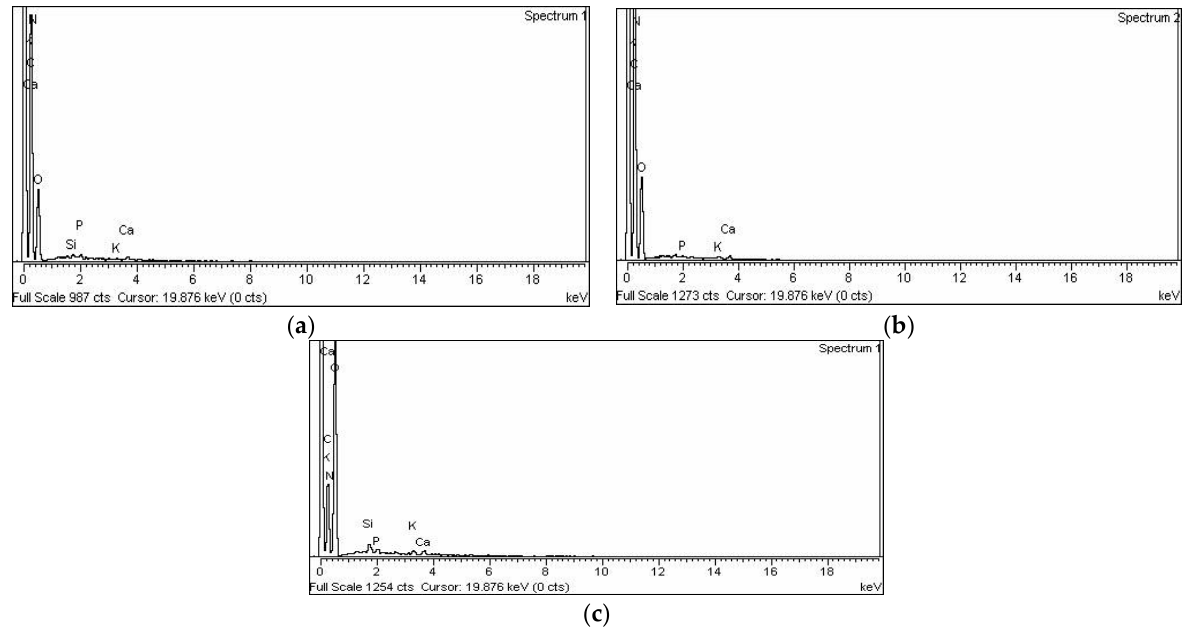
Figure 3. EDX spectra of ( a ) biomass ( b ), acid-treated AC and ( c ) base-treated AC. Table 2. EDX results of biomass and AC treated with acid and